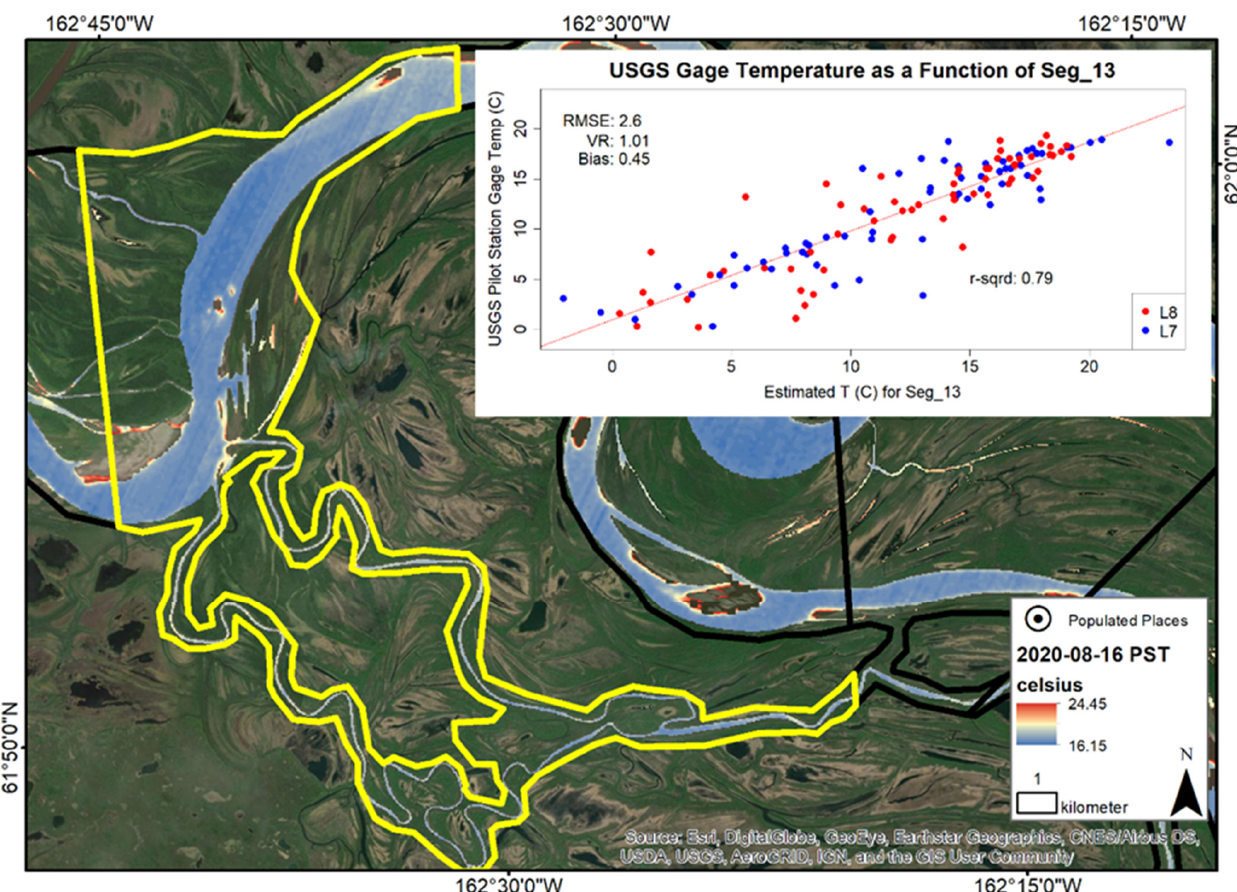
Figure A11. Segment 13 is unique in that it captures a portion of the northerly Center Slough and southerly Reindeer Creek River. We chose to include these extensions of the river due to their interconnectedness with the main flow as supported by the similar water temperature and sediment load that appears in these waterways. Despite a more unique distribution of water surface area, correlation between estimated (here) and measured (Pilot Station) water temperature remain good (RMSE = 2.6 °C, r 2 = 0.789). The pST coverage for open water within this section is 100% with no NoData gaps. Small sandbars are visible in the above scene. These bars grow in size as water levels drop and become inundated at high water stages. Wetlands surround all portions of this segment, and the Yukon River meanders around a large accreting point bar as it leaves the river segment.